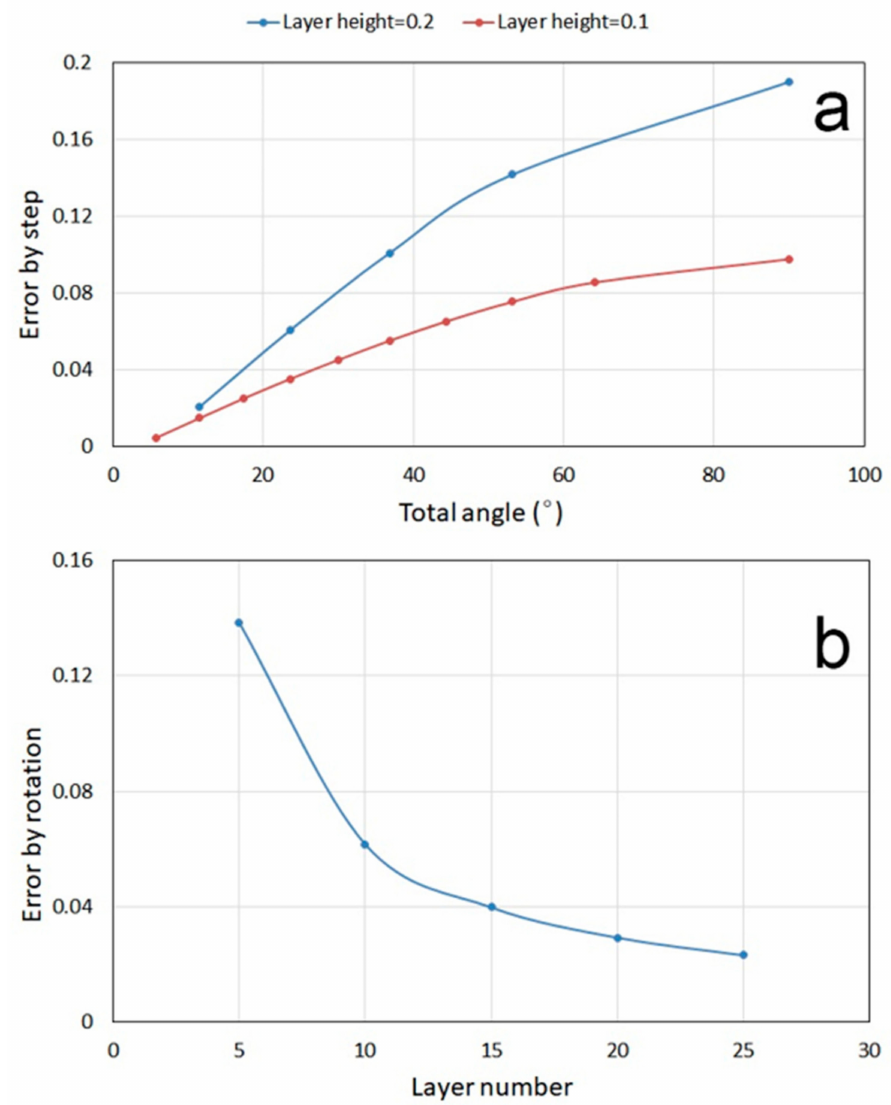
Figure 6. ( a ) Relation between layer height and theoretical manufacturing error (TME) from layer height, where total angle is the sum of α and θ ; ( b ) Relation between layer number and TME from layer